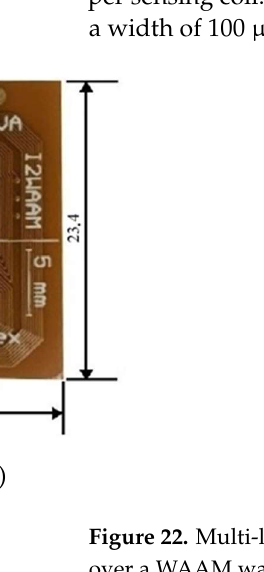
( b ) Figure 23. Multi-layer flexible PCB probe impedance output obtained from the inspection of an aluminum sample at a frequency of 1.5 kHz with: ( a ) a 1 mm diameter defect; ( b ) a 1.5 mm diameter defect. The results presented were selected as the best from a series of tests that were conducted on different specimens. However, it is important to note that the probes used in these tests did not consistently produce reliable results. This is due to the fact that the waviness and roughness of the specimens resulted in high amounts of noise that interfered with the defect signal. Additionally, it is worth mentioning that these tests were performed on finished WAAM walls at room temperature. If the tests were conducted in-line, meaning during the manufacturing process at high temperatures, it would require proper insulation of the probes to prevent damage and therefore increased lift-off. The increase in lift-off would further decrease the reliability of the inspection. Therefore, it is important to consider these limitations when evaluating the results and esspecially when considering in-line ECT inspection. 4.7. Hot-Forging WAAM Variant Hot-forging WAAM is a new variant of the WAAM process that uses a small hammer to forge the material deposited. This forging process is carried out while the material is